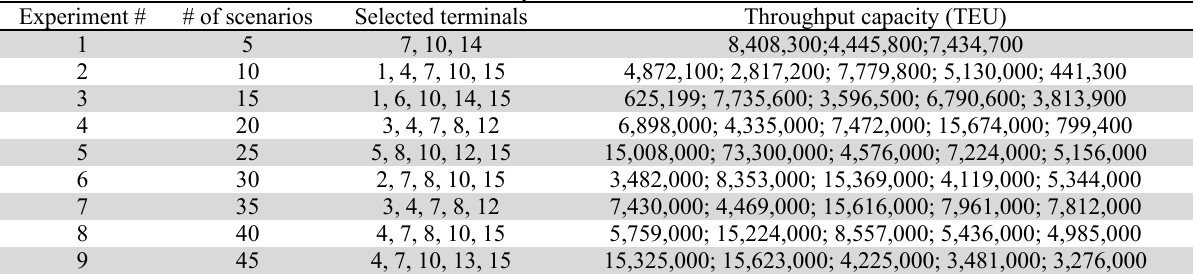
Solution of the robust model P1 for case study 2 Experiment